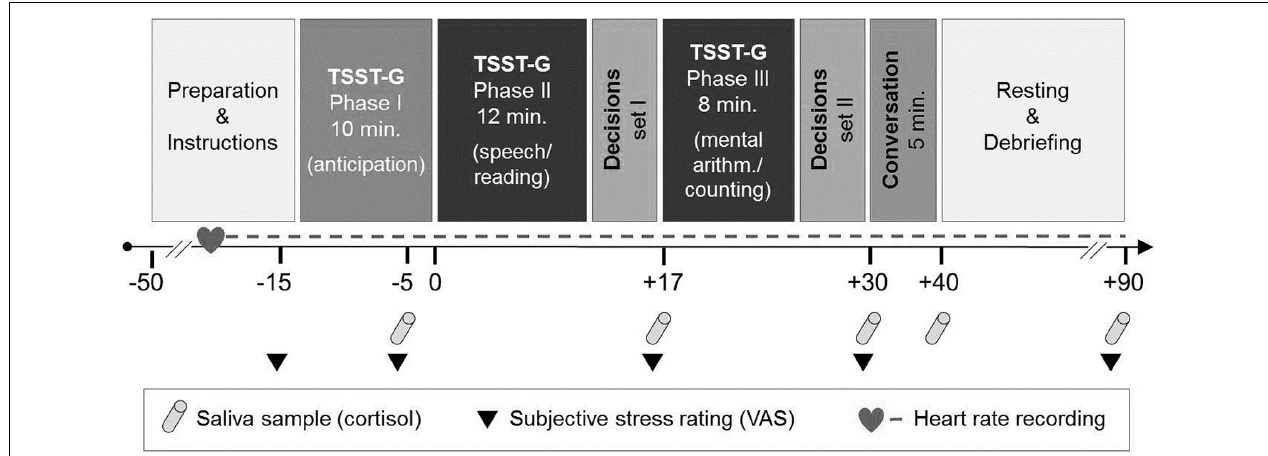
FIGURE 1 | Experimental course with stress induction and the social conversation paradigm [adapted from von Dawans et al. (35)]. TSST-G, Trier Social Stress Test for Groups. VAS, visual analogue scale.